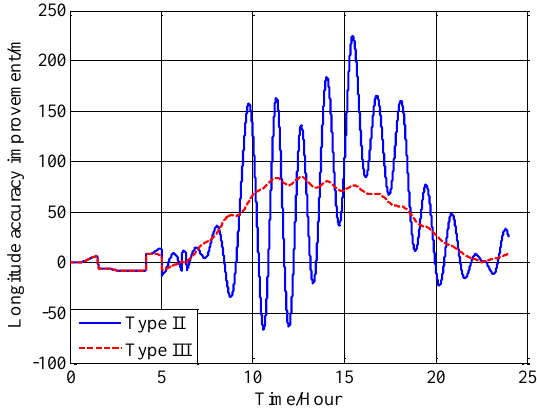
Figure 20. The precision improvement of longitude with compensation.